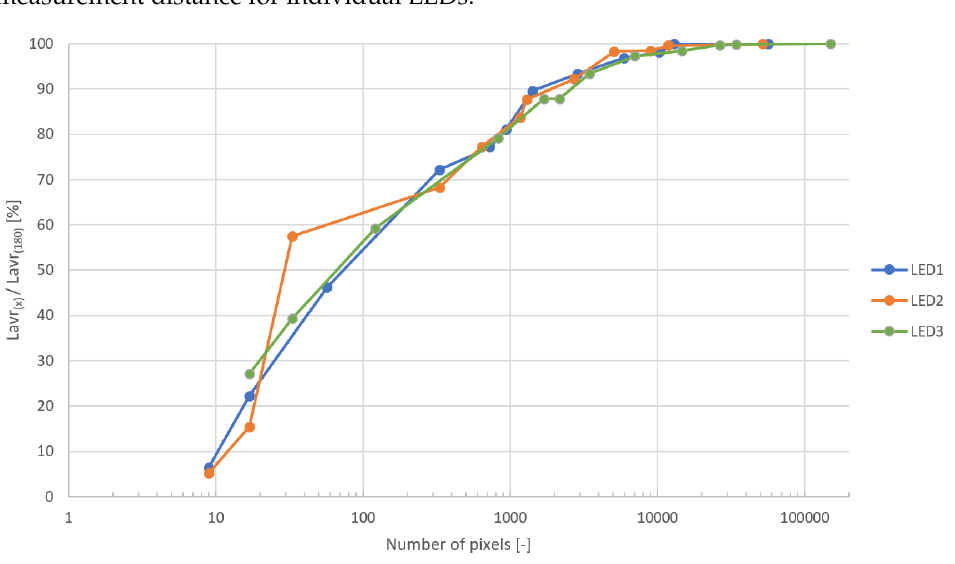
Figure 9. The relative average luminance (related to Lavr for 180 mm) for LED1, LED2 and LED3 as a function of the number of pixels on the ILMD array.